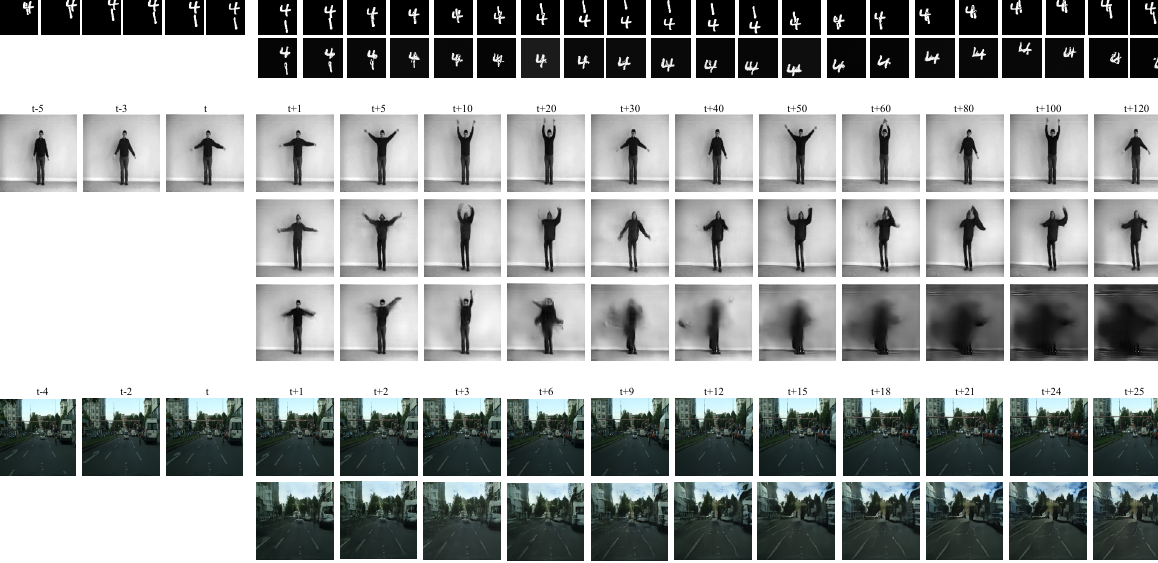
Figure 7. Prediction results of the long-term predictions for all three datasets. a: Input, b: Ground Truth, c: FutureGAN (ours), d: MCNet